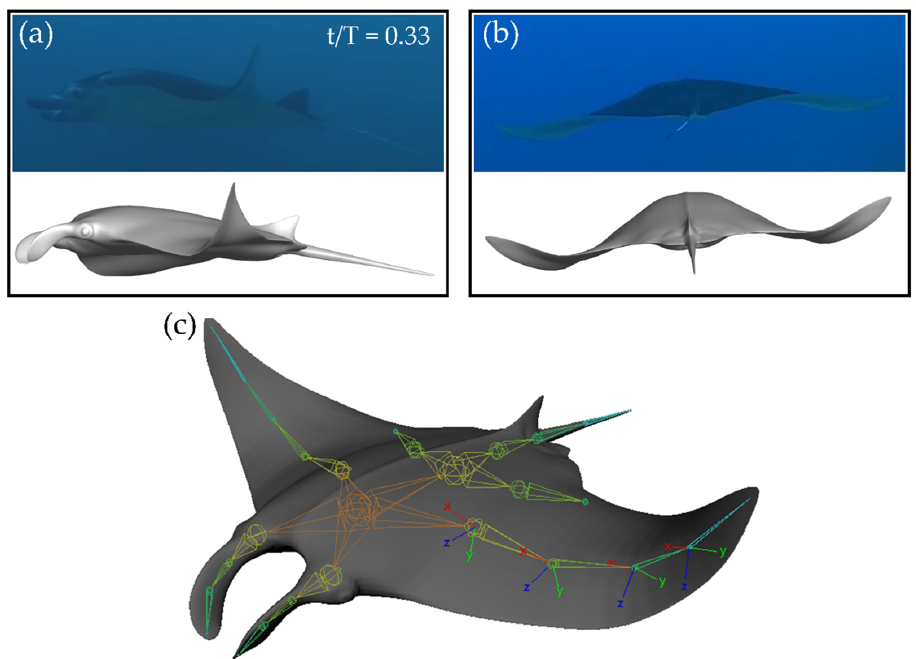
Figure 1. Comparison between biological motion and prescribed manta-like motion from side ( a ) and back ( b ) views at T = 0.33. ( c ) Skeletal joint arrangement for the current model.